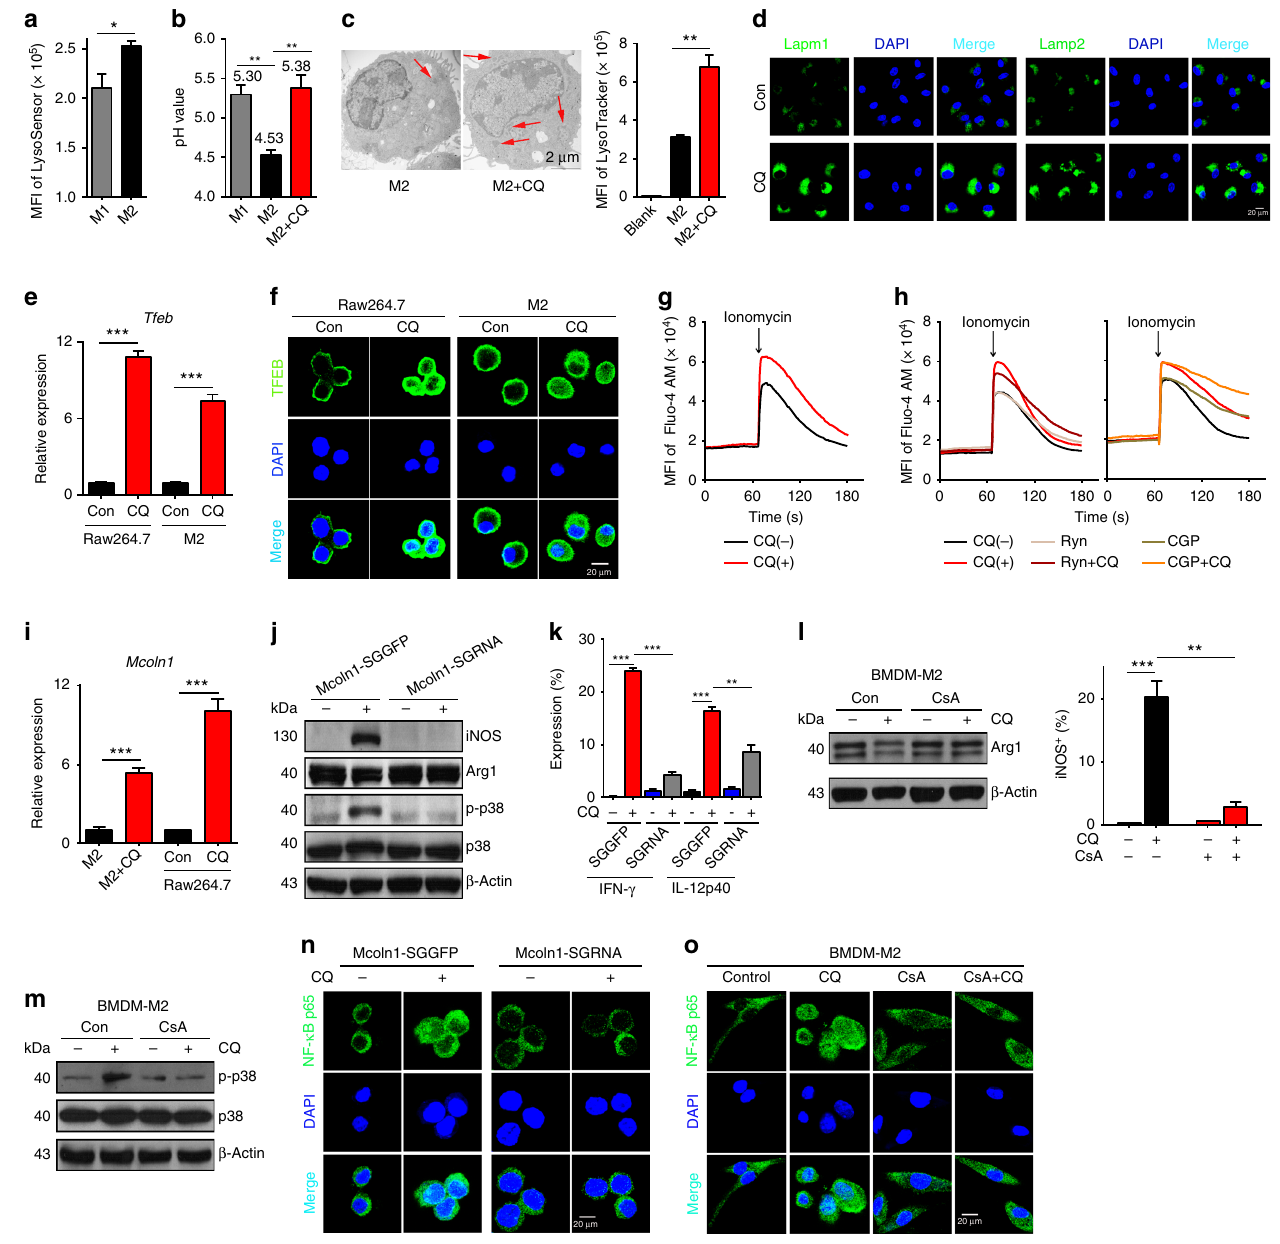
Fig. 5 Lysosomal Ca 2 + release activates p38 and NF- κ B. a The mean fl uorescence intensity (MFI) as lysosomal pH in BMDM-M1 and BMDM-M2 cells ( n = 3). b The lysosomal pH value of BMDM-M1, BMDM-M2, and CQ-treated BMDM-M2 cells ( n = 3). c Left: representative picture of lysosomes